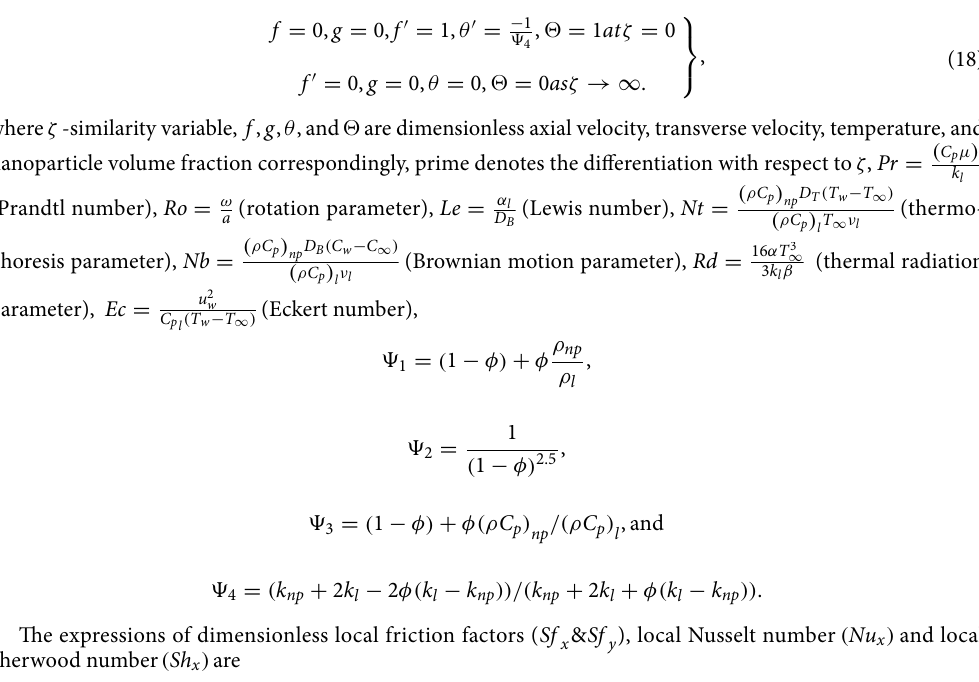
The expressions of dimensionless local friction factors ( Sf x & Sf y ), local Nusselt number ( Nu x ) and local Sherwood number ( Sh x ) are